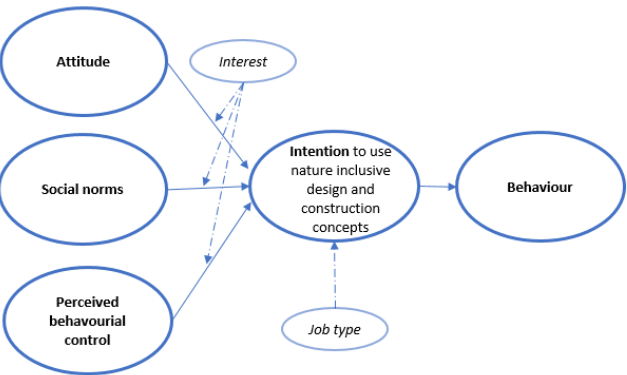
Figure 1. Conceptual model of this study based on the Theory of Planned Behavior (TPB). The solid arrows show the relationship between the TPB’s variables and the dashed arrows show the effects of the additional variables. the additional